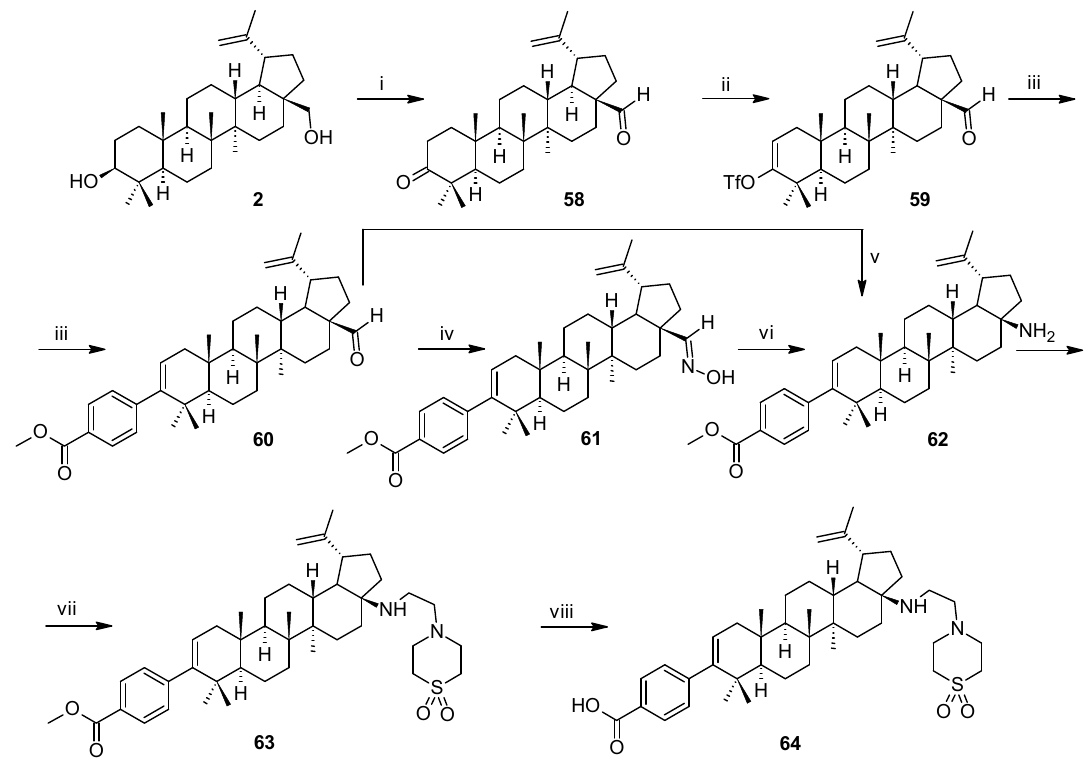
Figure 2. Structures of the HIV-1 maturation inhibitors based on betulinic acid ( 1 ).